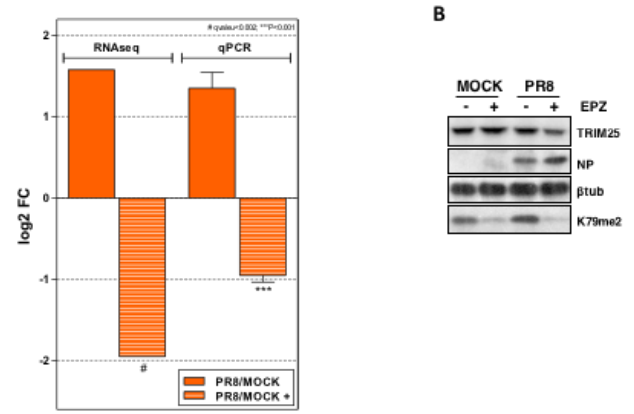
Figure 6. Changes of TRIM25 in control and Dot1L inhibited cells. ( A ) Comparison of the TRIM25 expression from the RNA-seq and qRT-PCR data of A549 cells that were untreated or treated with EPZ (1 μM, 48 h) and then infected with PR8 at MOI 3 for 8 h. The differences between the untreated and treated cells were analyzed and are represented as the log2 fold change. Three technical replicates of three independent experiments for qRT-PCR detection were performed.. ns p > 0.05; * p < 0.05; ** p < 0.01; *** p < 0.001. ( B ) The total extracts of untreated or EPZ-treated cells, non-infected or infected with PR8 were used for Western blot analysis against the indicated proteins.